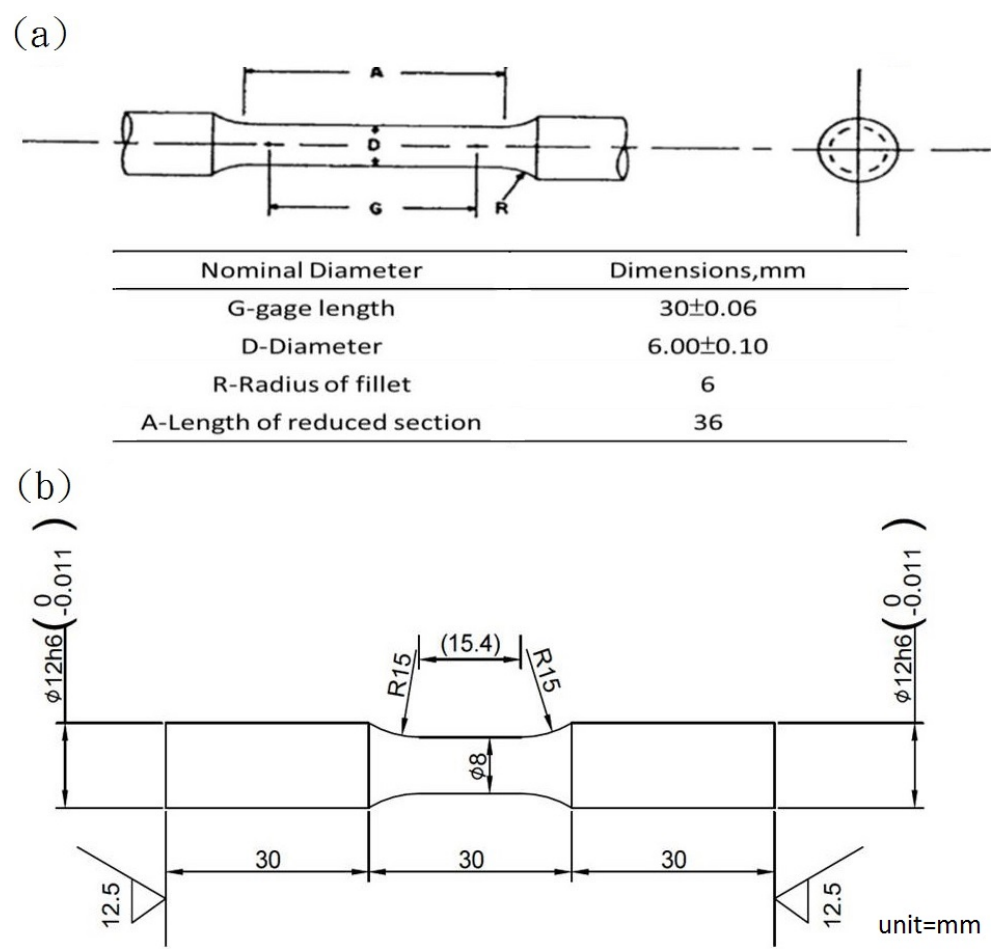
Figure 1. The dimensions of specimens used for ( a ) tensile test (gage diameter: 6 mm); and ( b ) rotating bending test (gage diameter: 8 mm).